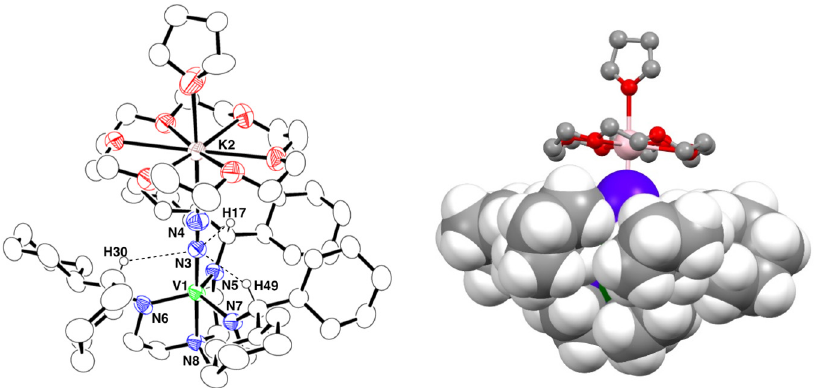
Figure 5. ( Left ) X-ray structure of 4 with the atom numbering scheme (50% probability thermal ellipsoids). The hydrogen atoms, except for the hydrogen on the methine carbons neighboring on the terminal N atoms of the triamidoamine ligand, disordered atoms, and crystal solvates are omitted for clarity. ( Right ) Side view of space-filling model of 4 . The hydrogen atoms of THF and 18-crown-6-ether are omitted, and the potassium ion, 18-crown-6-ether, and THF are shown in ball and stick model for clarity (C, H, N, O, K, and V are shown in gray, white, blue, red, pink, and green colors, respectively).